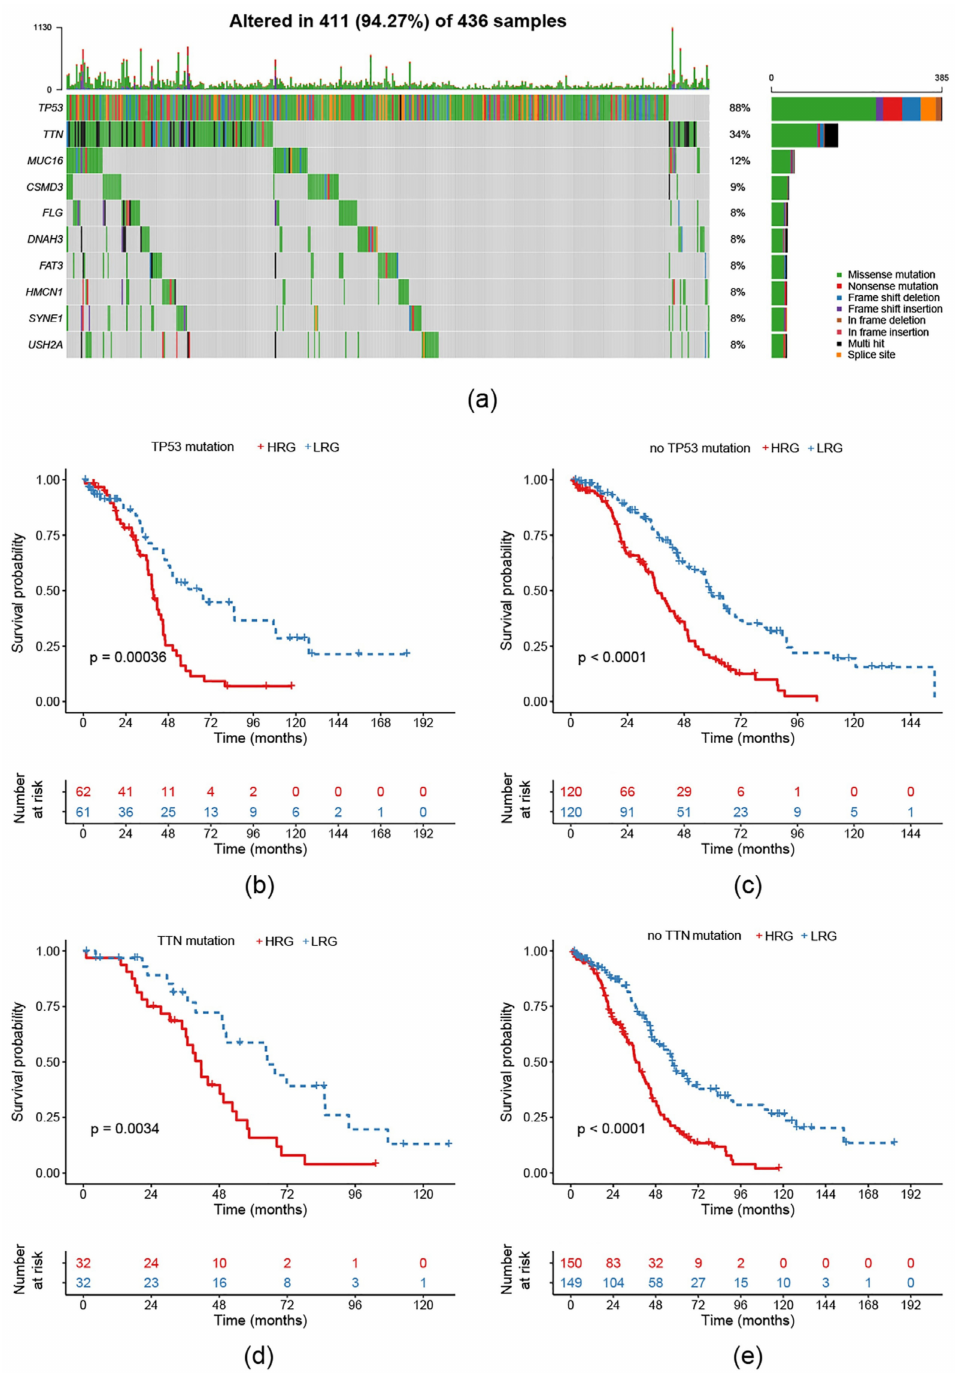
Figure 6. Analysis of the 11-gene signature model in different single nucleotide mutations: ( a ) Distribution ofcommonsinglenucleotidemutationsinEOCwith94.27%samplesaltered; ( b )KMcurveofTP53-mutated samples; ( c ) KM curve of not TP53-mutated samples; ( d ) KM curve of TTN-mutated samples; ( e ) KM curve of not TP53-mutated